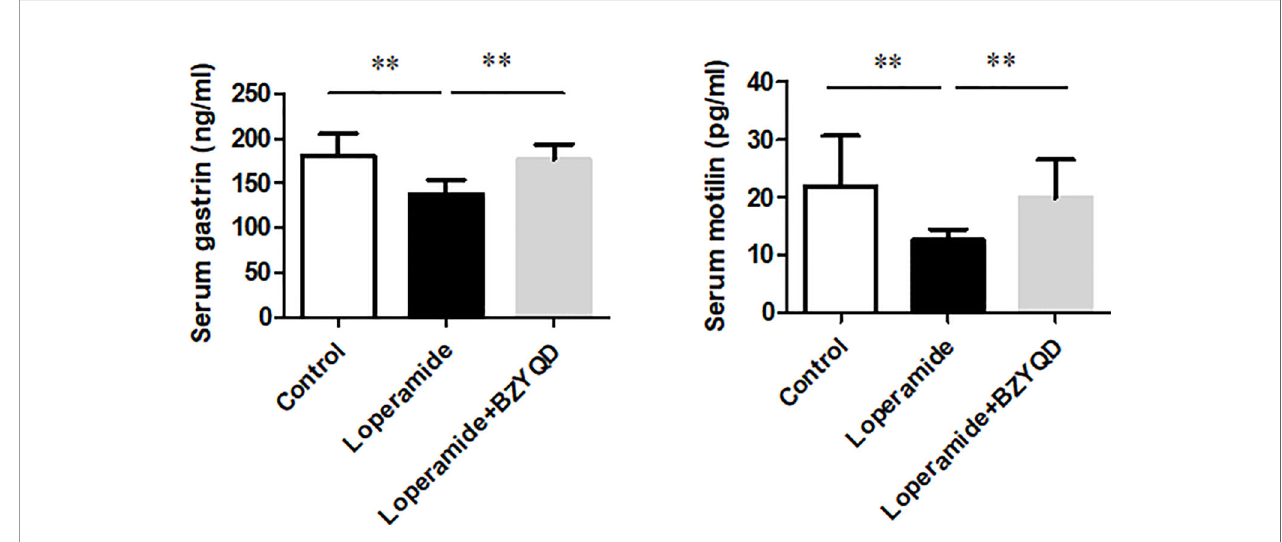
FIGURE 9 | Effect of BZYQD intervention on serum levels of motilin and gastrin in loperamide-treated rats. Data are represented as mean ± SD; n = 5. ** P < 0.01 between